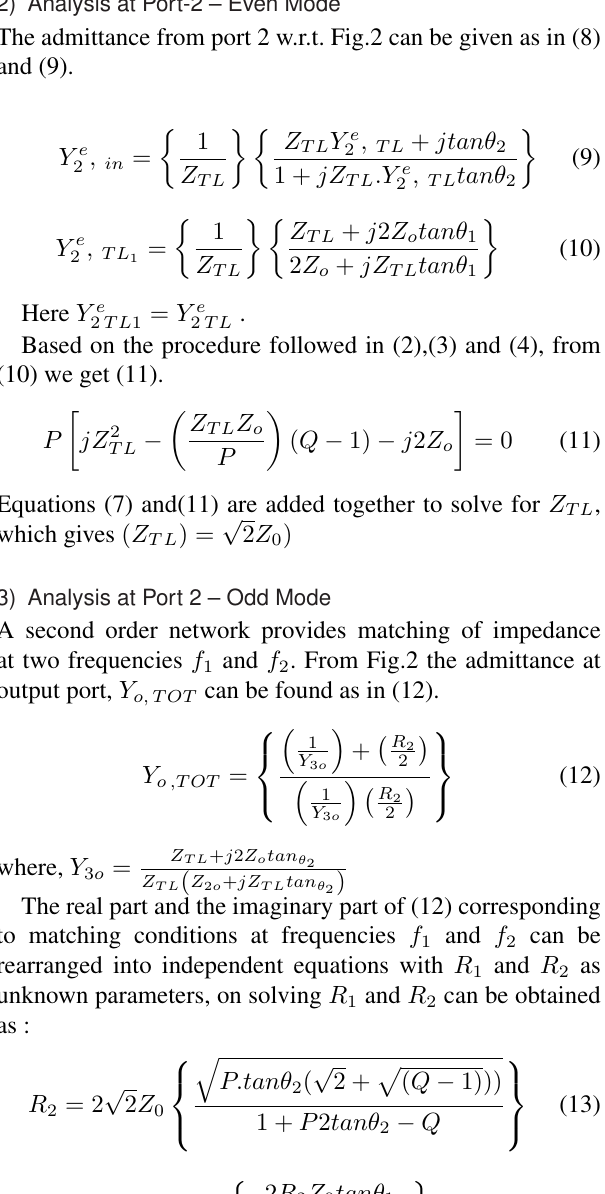
Here P = ( tanθ 1 + tanθ 2 ) and Q = ( tanθ 1 tanθ 2 )